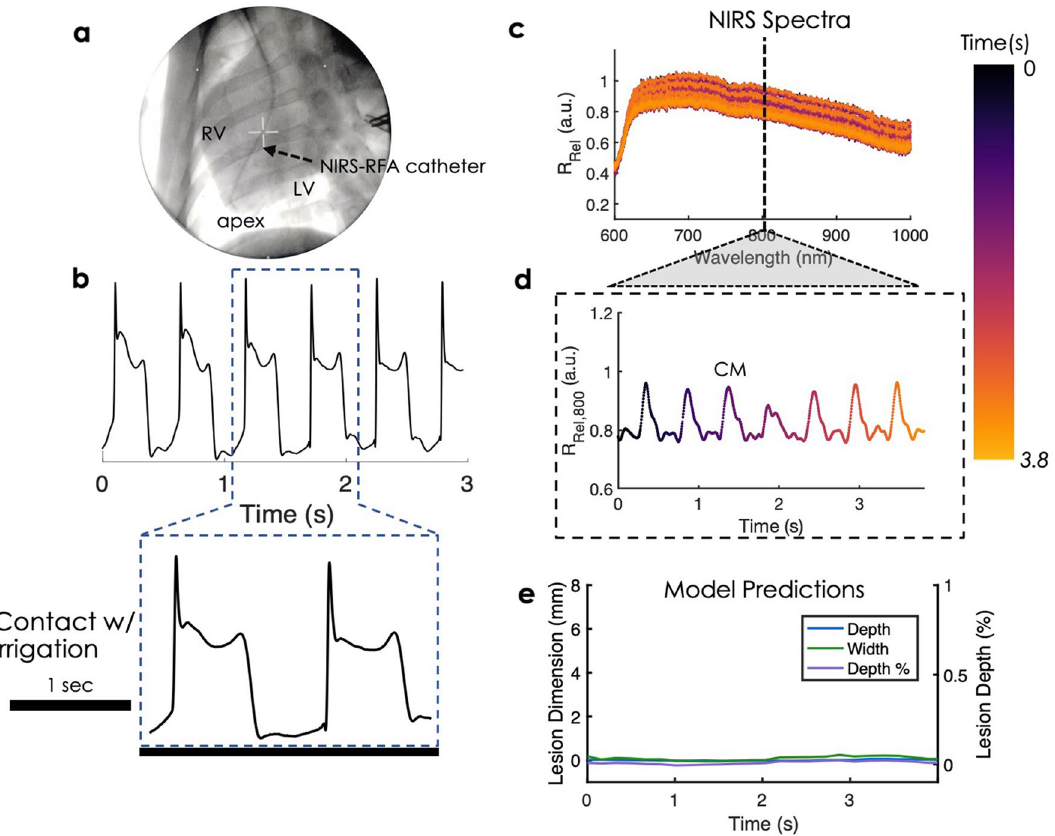
Figure 6. In vivo deployment of NIRS-RFA catheter. ( a ) Shows NIRS-RFA catheter placement at the apex under fluoroscopic guidance. ( b ) Shows bipolar electrogram measurements indicating good catheter contact with tissue. ( c ) Shows corresponding temporal fluctuations of R Rel spectra over the cardiac cycle. ( d ) Shows amplitude variations at 800 nm reflecting a similar periodicity to the bipolar electrogram. CM cardiac motion. ( e ) Shows the corresponding gaussian process regression model outputs with relatively stable predictions under cardiac motion of near zero values for untreated, normal